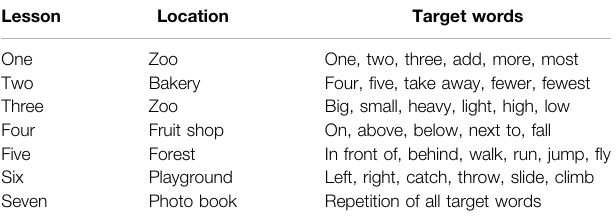
TABLE 2 | Overview of the lesson series and target